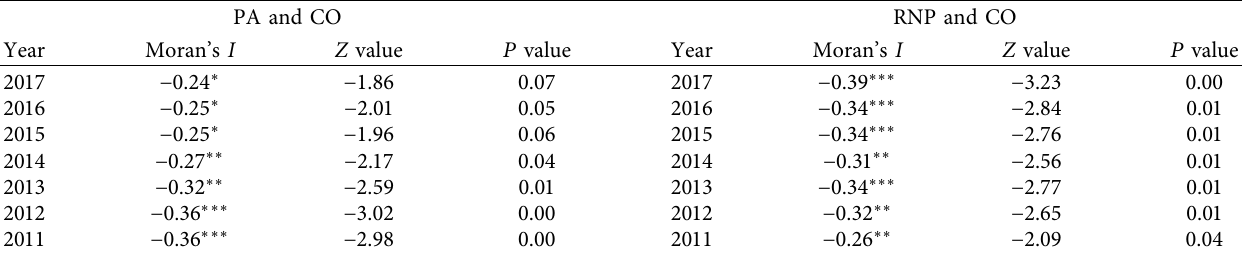
Table 5: The results of bivariate global Moran